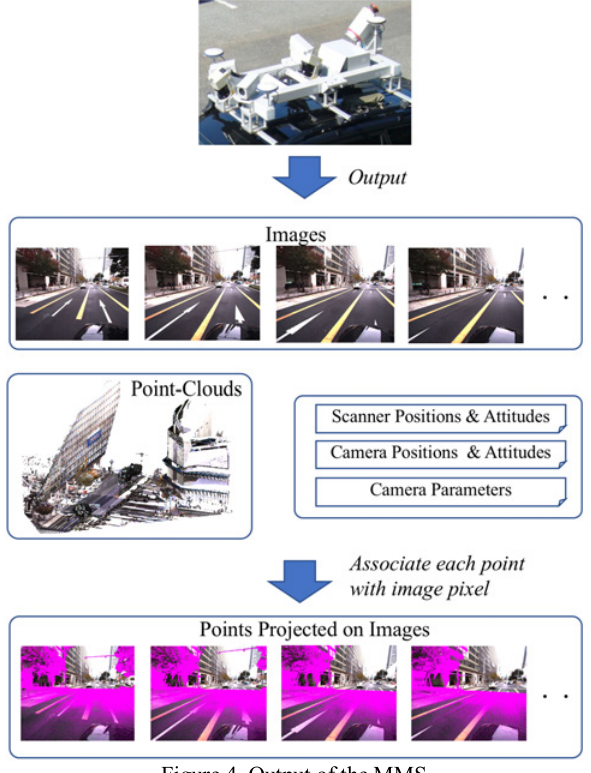
Figure 4. Output of the MMS